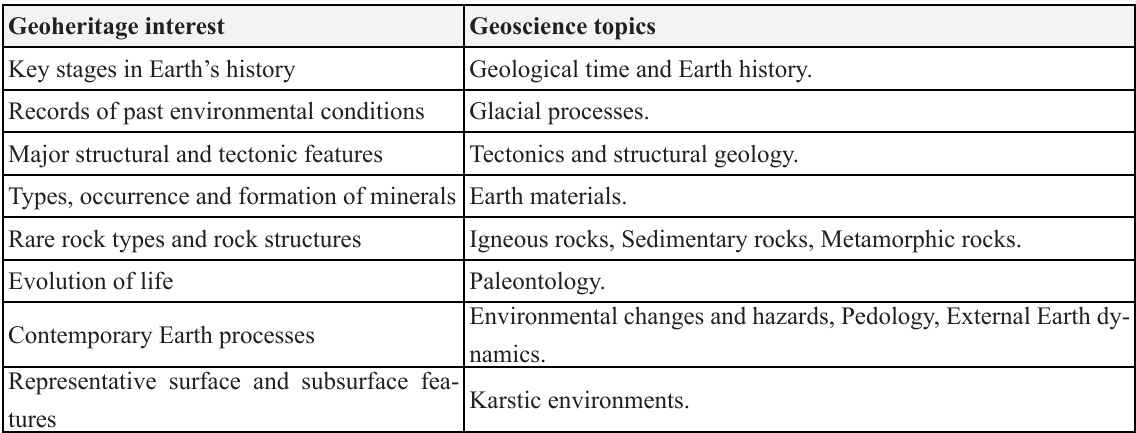
Table 2. Comparison between the geoheritage interest themes from Crofts et al. (2020) with the geoscience topics of the analyzed educational materials. In this comparison, geoscience topics that have close links with geoheritage interests are